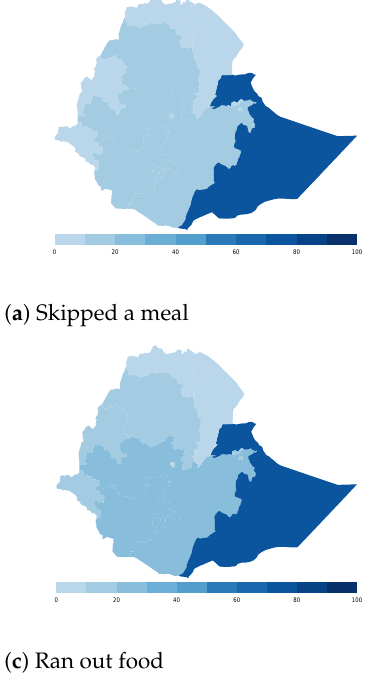
Figure 5. Ethiopia—share of households.